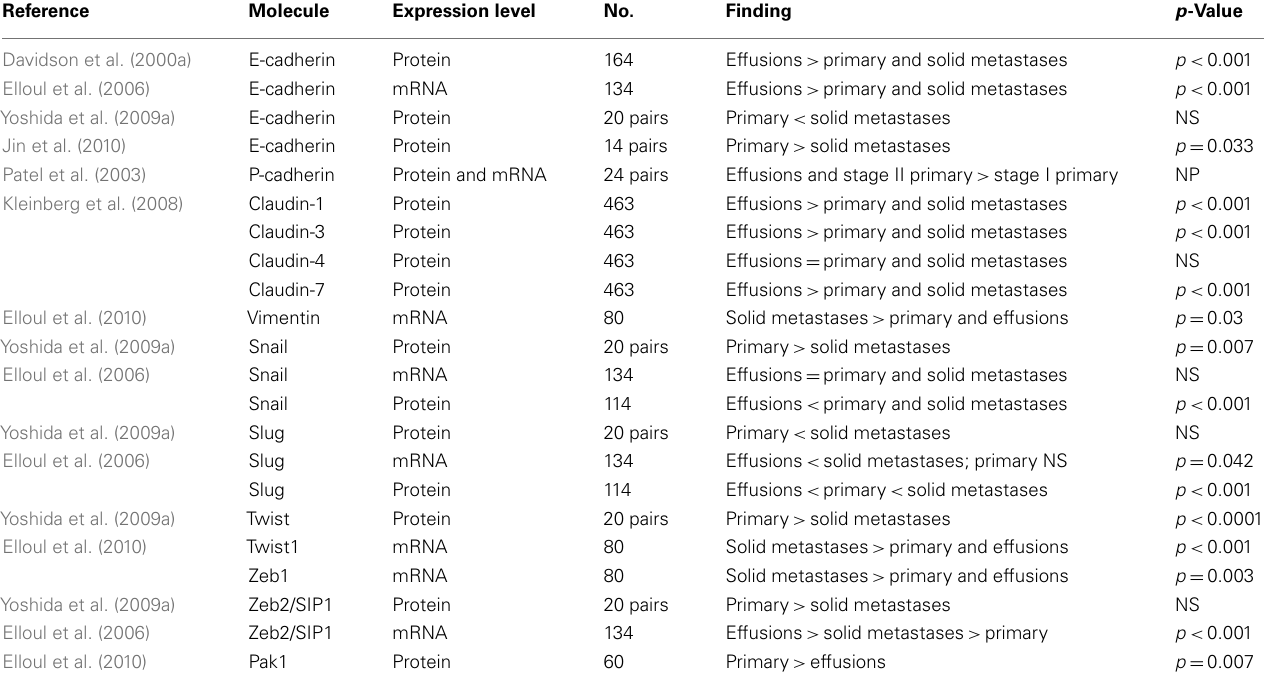
Table 1 | Molecules related to epithelial-to-mesenchymal transition in clinical ovarian carcinoma specimens – association with disease